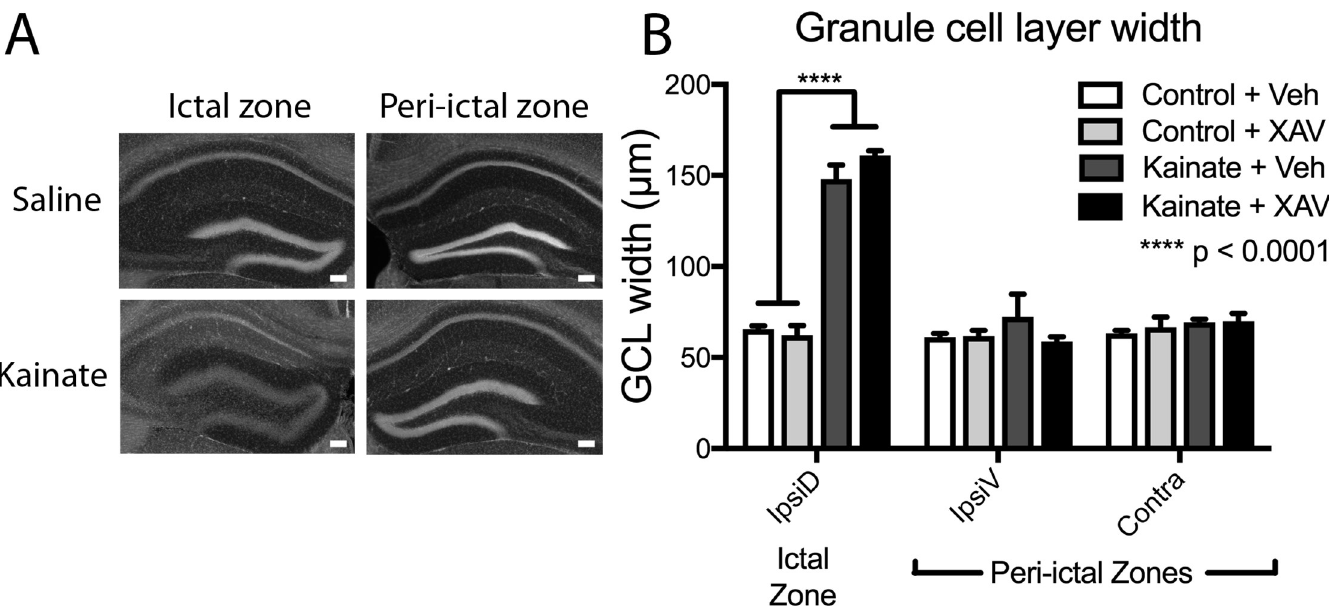
Fig 3. Granule cell dispersion in the ictal zone is not affected by XAV939 treatment. (A). DAPI-stained images of coronal whole dentate gyrus after saline (control) and kainate injection in the ictal (injected) and peri-ictal (non-injected) regions of the dentate gyrus. Scale bar 100 μ m. (B). Dentate granule cell layer dispersion is only seen in the ictal zone after seizure induction by kainate, and this was not affected by daily administration of Wnt antagonist XAV939 for two weeks after kainate.